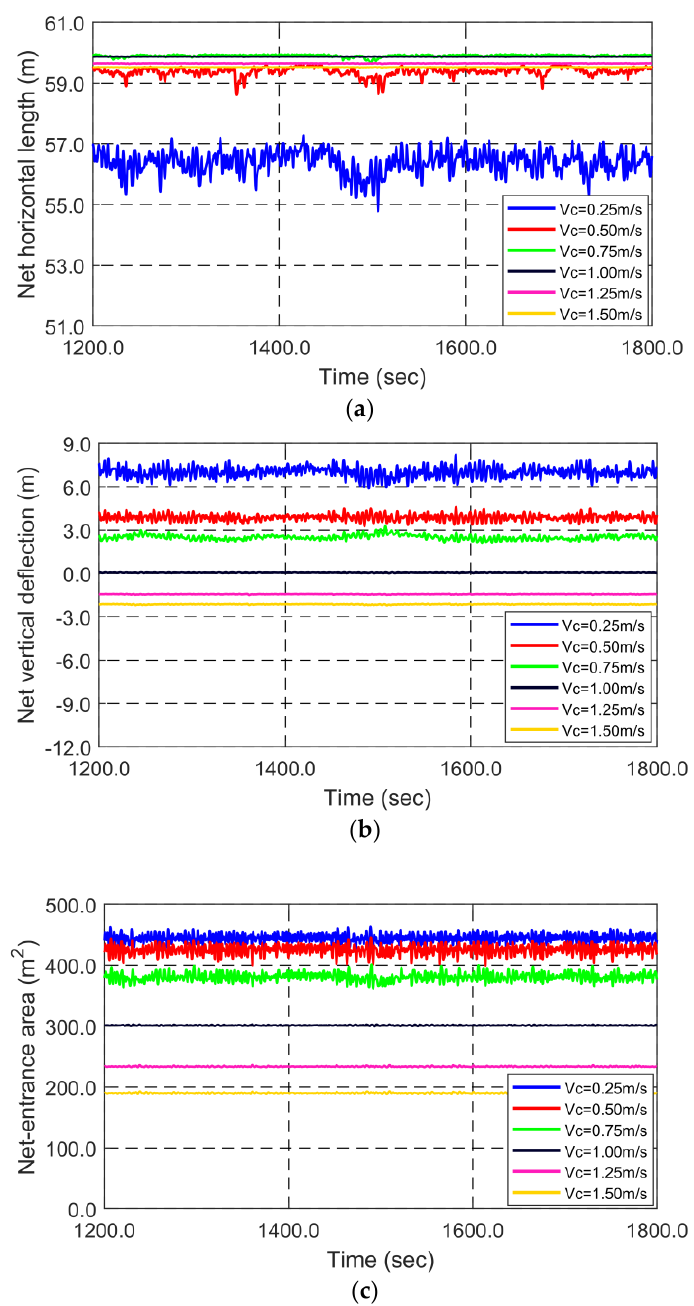
Figure 6. Time histories of net horizontal length ( a ), net vertical deflection ( b ), and net-entrance area ( c ) at varying current velocities under identical wave excitations ( H s = 1.0 m, T p = 5.25 sec). Table 3. Statistical data of net horizontal length, net vertical deflection and net-entrance area for all simulated cases.